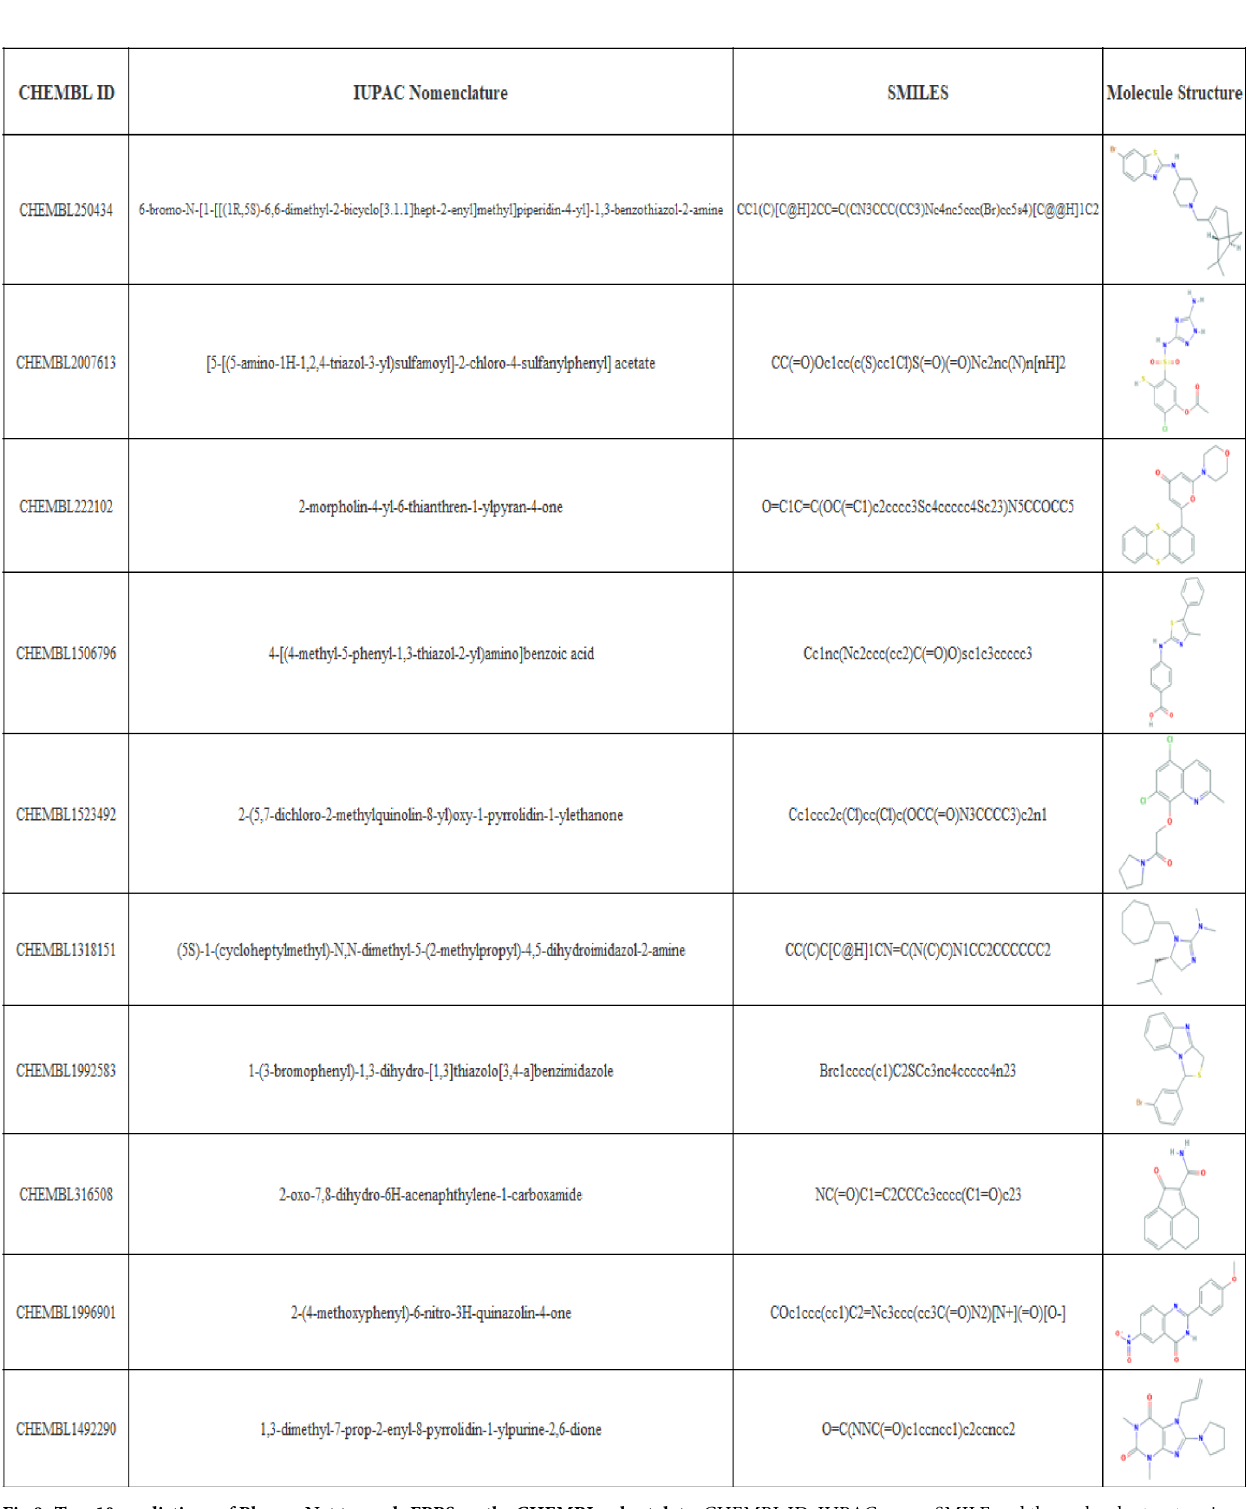
PLOS ONE | https://doi.org/10.1371/journal.pone.0241728 April 26,